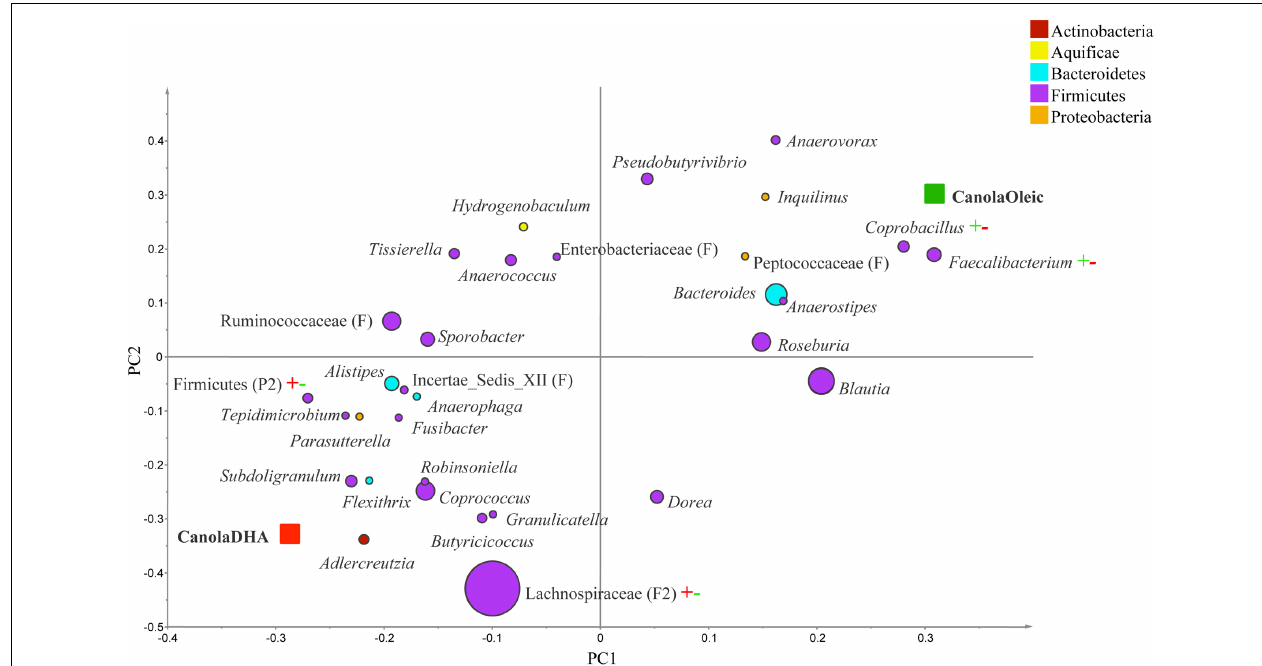
FIGURE 3 | Partial least square discriminant analysis loading plot based on the relative abundances of bacterial genera in the gut microbiota and their association with CanolaDHA or CanolaOleic diets. The presenting genera are chosen at VIP cutoff of 1.0 and colored according to their corresponding phyla. The size of circles is indicative of taxa abundance. Taxa closer to CanolaDHA or CanolaOleic diets indicate positive association with either treatment group. The R 2 ( = 0.78) and Q 2 ( = 0.45) estimates were calculated based on three components. While majority of sequences were identified at the genus level (G), some could only be affiliated to phylum (P), class (C), order (O), or family (F) levels.